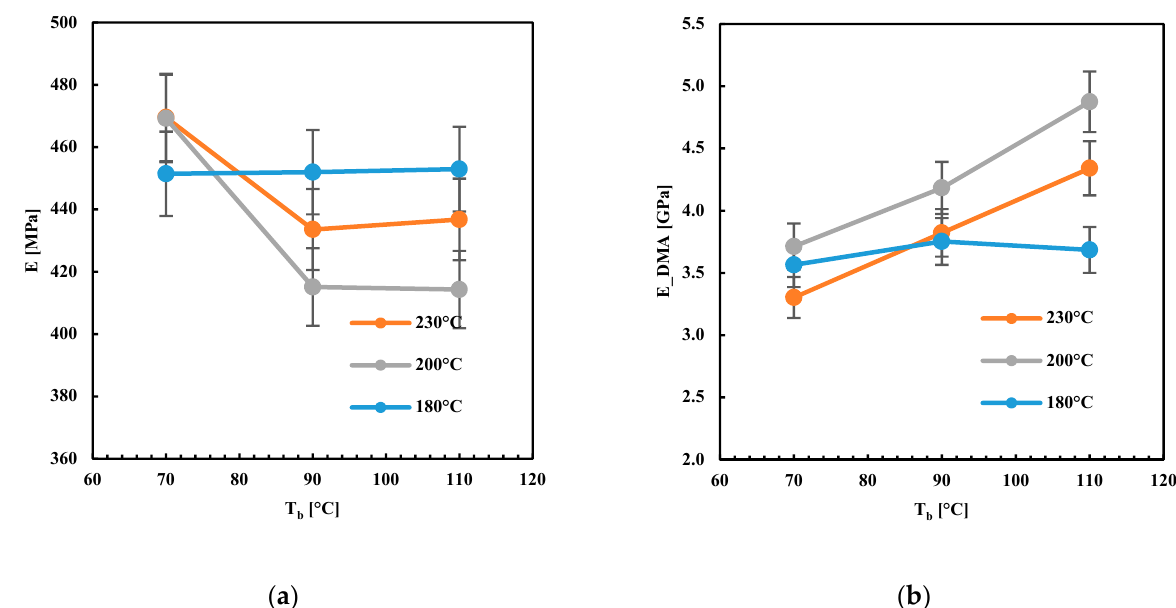
Figure 9. Elastic modulus ( a ) from tensile and ( b ) DMA analyses plot versus the plate deposition temperature T b at different nozzle temperatures.